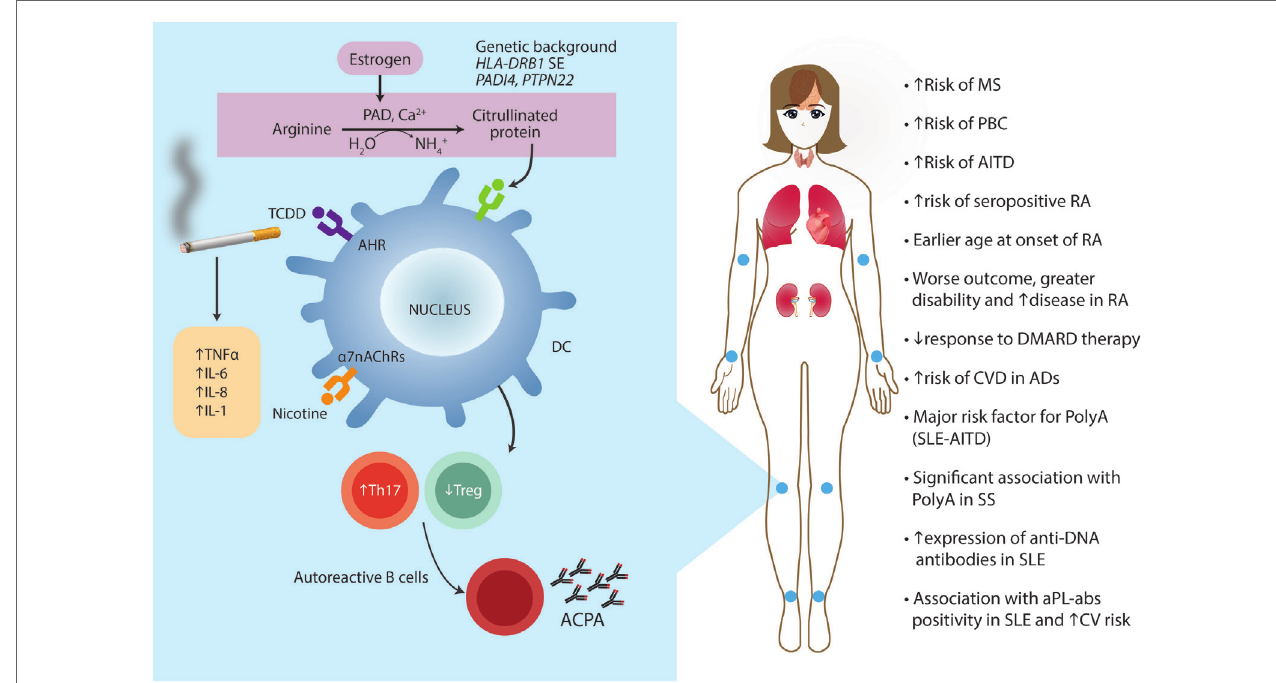
FiGURe 11 | Cigarrete smoking and autoimmunity . In predisposed individuals carrying certain autoimmune alleles at HLA-DRB1, PTPN22, and PADI4 genes, cigarette smoke triggers citrullination by activating PAD enzyme, a mechanism that is estrogen dependent. Citrullinated proteins act as auto-antigens and induce the formation of anticitrullinated protein autoantibodies (ACPAs) by autoreactive B cells. 2,3,7,8-tetrachlorodibenzo-p-dioxin (TCDD), released during cigarette smoking, acts as the best-known ligand for aromatic hydrocarbon receptor (AhR). AhR activation induces boosts T helper 17 (Th17) cells. Nicotine stimulates the α 7-nicotine acetylcholine receptors ( α 7nAChRs), and increases TNF α , IL-6, IL-8, and IL-1 synthesis. The effect on T regulatory (Treg) function is controversial. All of these molecular pathways are responsible for the clinical manifestations listed on the right. PAD, peptidylarginine deiminase; SE, shared epitope; DC, dendritic cell; MS, multiple sclerosis; PBC, primary biliary cirrhosis; AITD, autoimmune thyroid disease; RA, rheumatoid arthritis; DMARD, disease-modifying antirheumatic drug; CVD, cardiovascular disease; ADs, autoimmune diseases; PolyA, polyautoimmunity; SLE, systemic lupus erythematosus; SS, Sjögren syndrome; aPL-abs, antiphospholipid